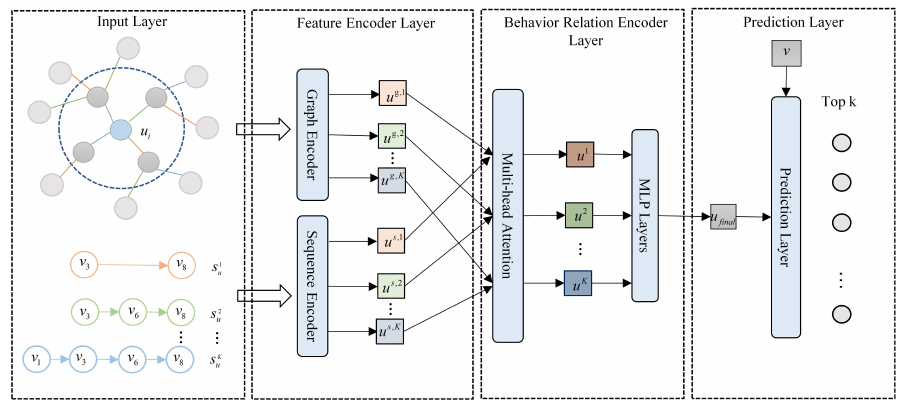
Figure 2. Model architecture of